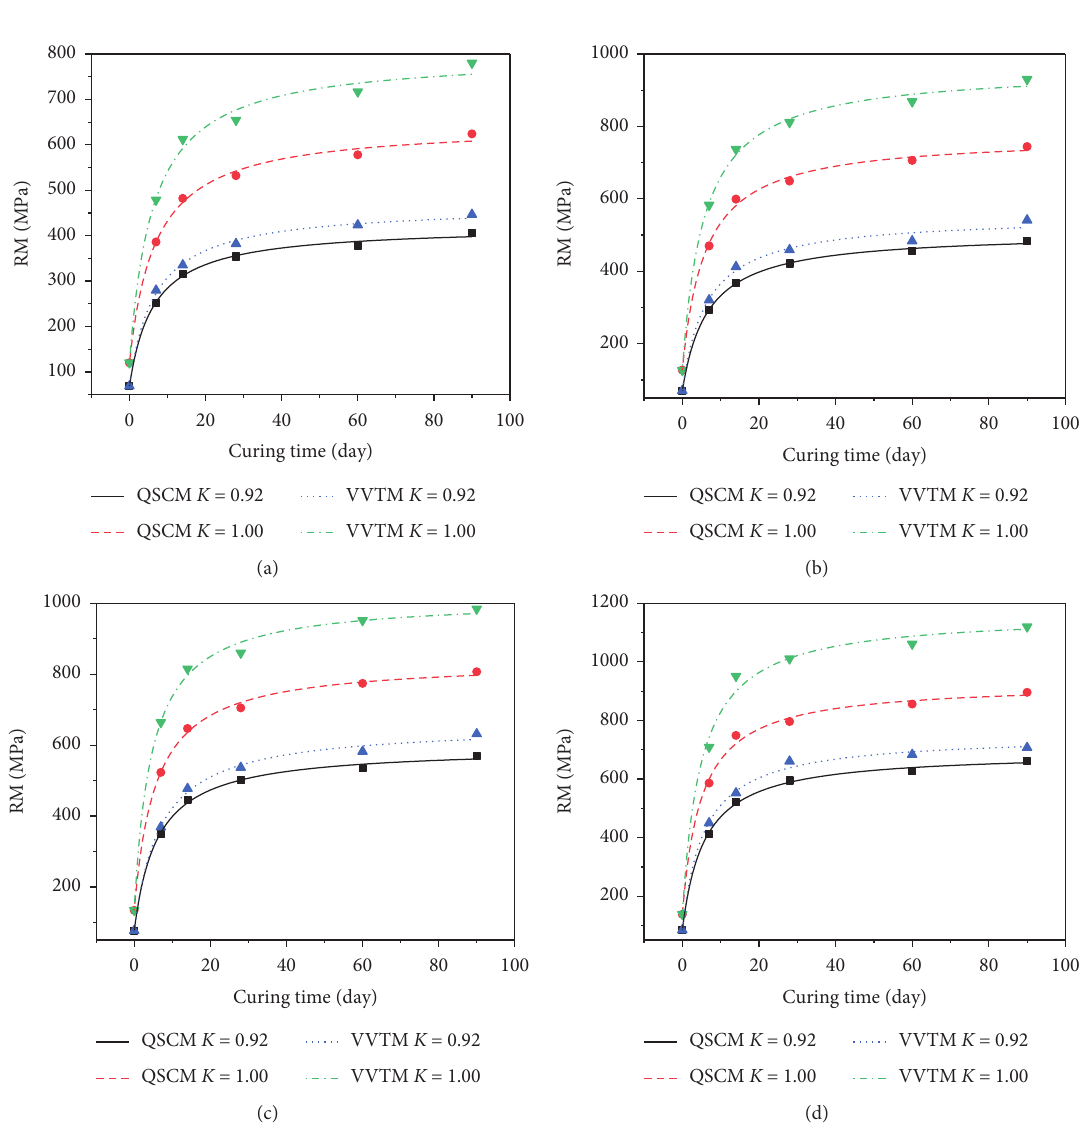
Figure 12: Influence of curing time on RM of CSL compacted using VVCM and QSCM. (a) Cement content � 3%. (b) Cement content � 4%. (c) Cement content � 5%. (d) Cement content � 6%. Table 12: Comparison of UCS among specimens compacted using VVCM, QSCM, and FCSs.